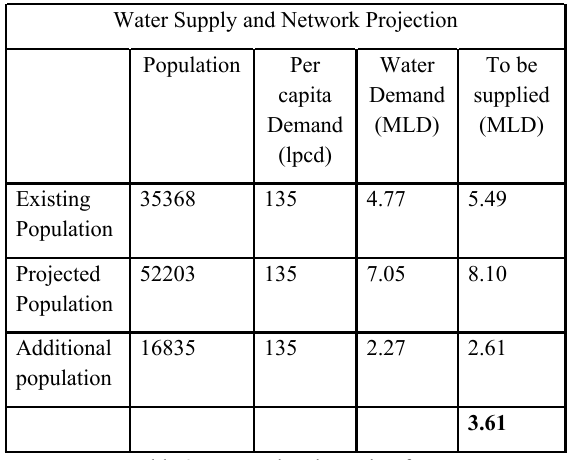
Table 3. Demand and supply of water 4.2.2